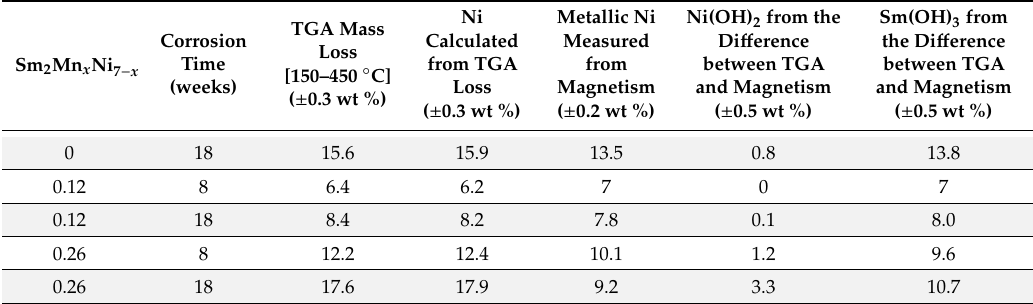
Table 3. TGA mass loss and estimated wt % of nickel obtained from this mass loss if attributed to Sm(OH) 3 amount, compared to the wt.% of nickel measured from magnetic measurements. The di ff erence between the Ni wt % given by the two techniques enables us to estimate the Ni(OH) 2 wt